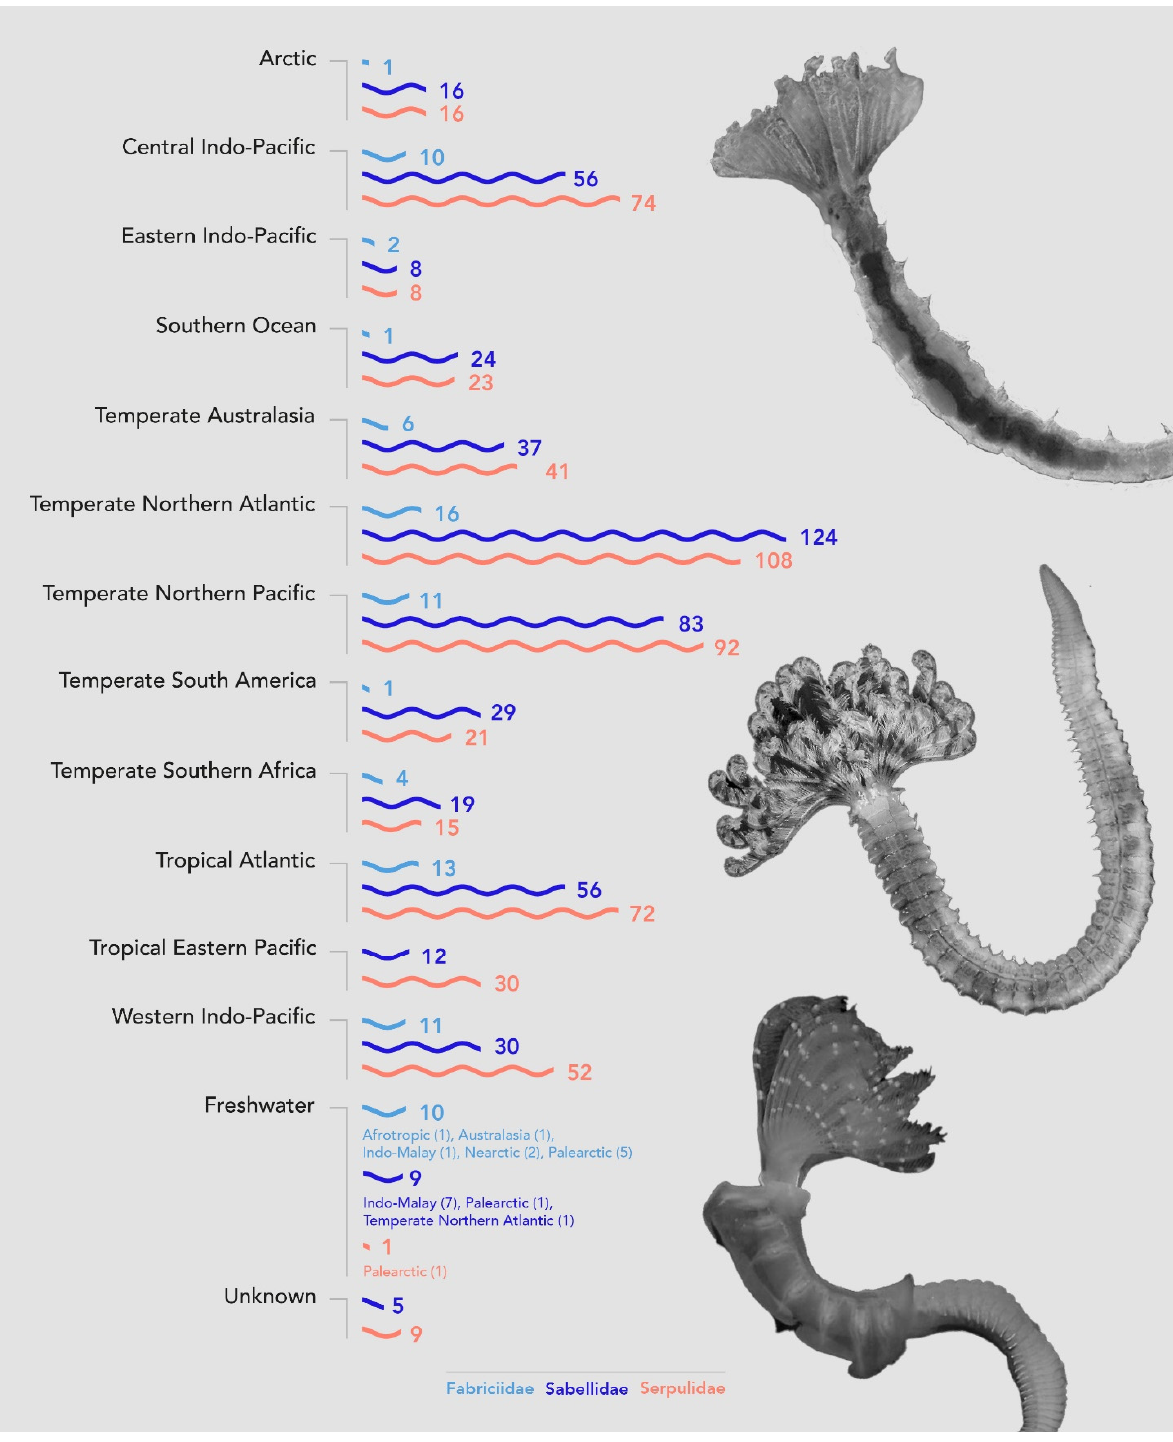
Figure 7. Number of species described for each marine realm (in alphabetical order, according to Spalding et al. [31]) and Udvardy 1975 for limnic realms.